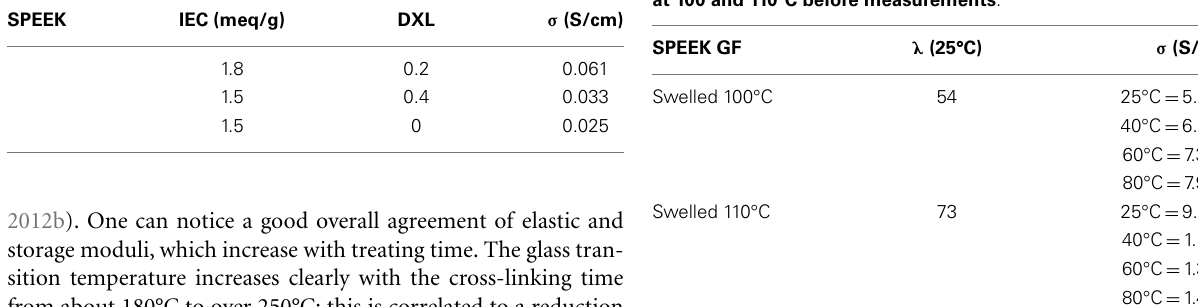
Table 4 | Conductivity data in full humidify condition for SPEEK GF, treated at 180°C/8h with a final IEC of 1.96meq/g (DXL = 26) swelled at 100 and 110°C before measurements